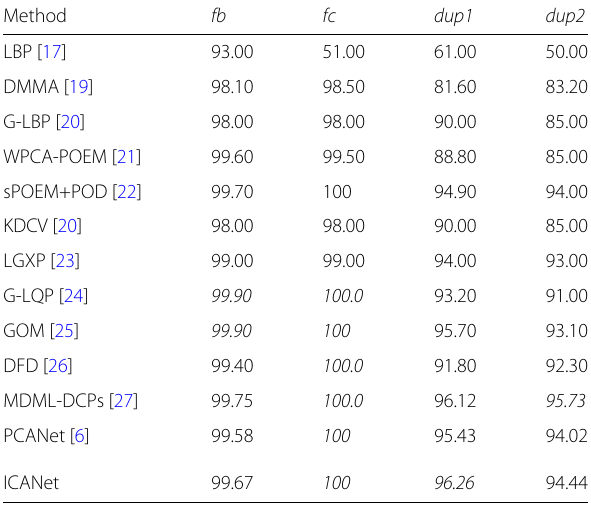
Table 3 Performance comparison of ICANet with other algorithms using the FERET database fb and fc represent expression and light changes, and dup1 and dup2 represent age